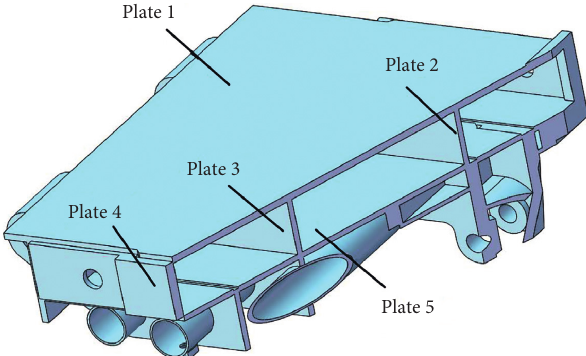
Figure 2: The sectional view of the box structure-based tail beam.